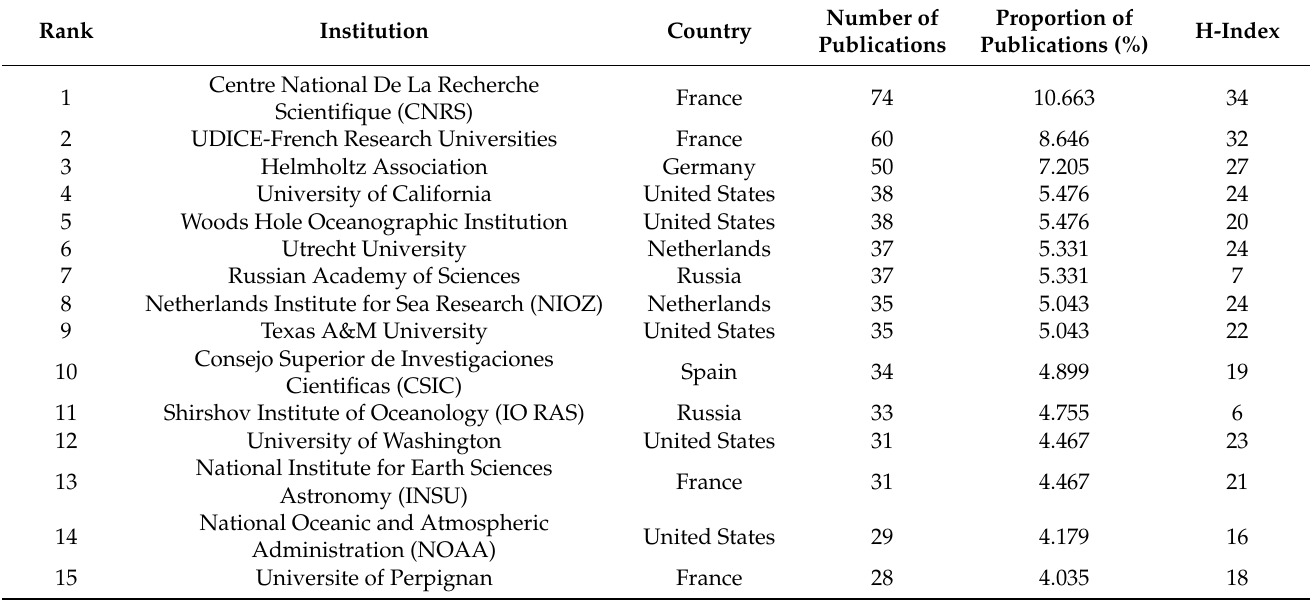
Table 1. Top 10 institutions with the most publications related to nepheloid layers from 1990 to 2022.